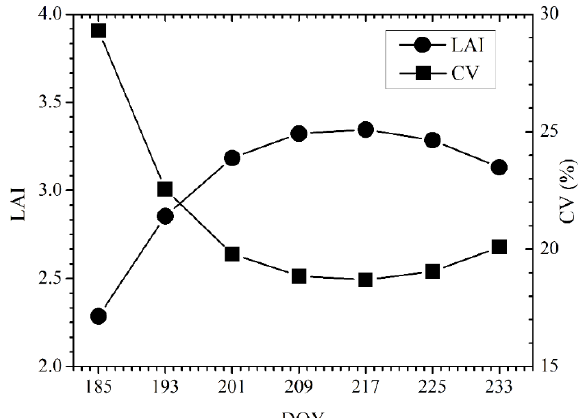
Figure 5. The temporal variation of average LAI and uncertainty values in our study